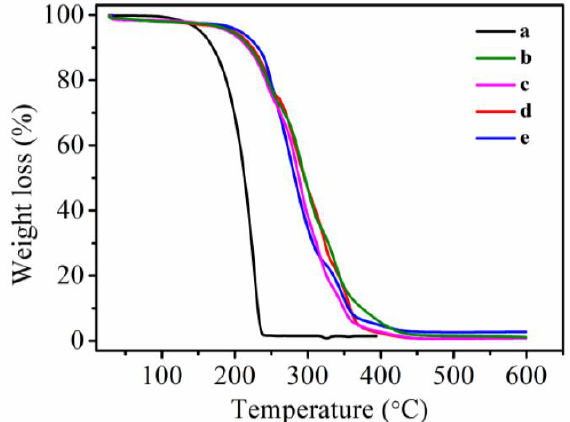
Figure 10. Thermal gravity analysis (TGA) curve comparison of various MicroPCMs and pure ethyl palmitate: ( a ) ethyl palmitate; ( b ) polyurea microcapsules; ( c ) polyurethane microcapsules; ( d ) polyurea–SiO 2 microcapsules; ( e ) polyurethane–SiO 2 microcapsules.